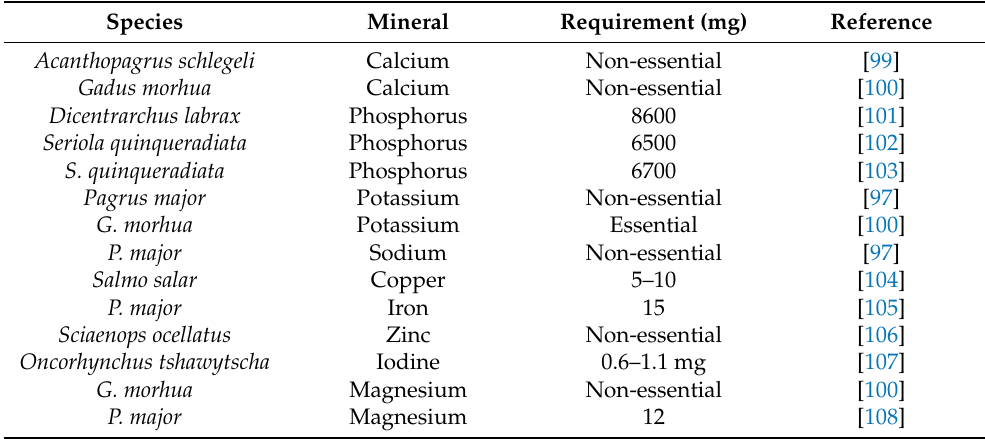
Table 11. Macro- and micromineral requirements for various juvenile